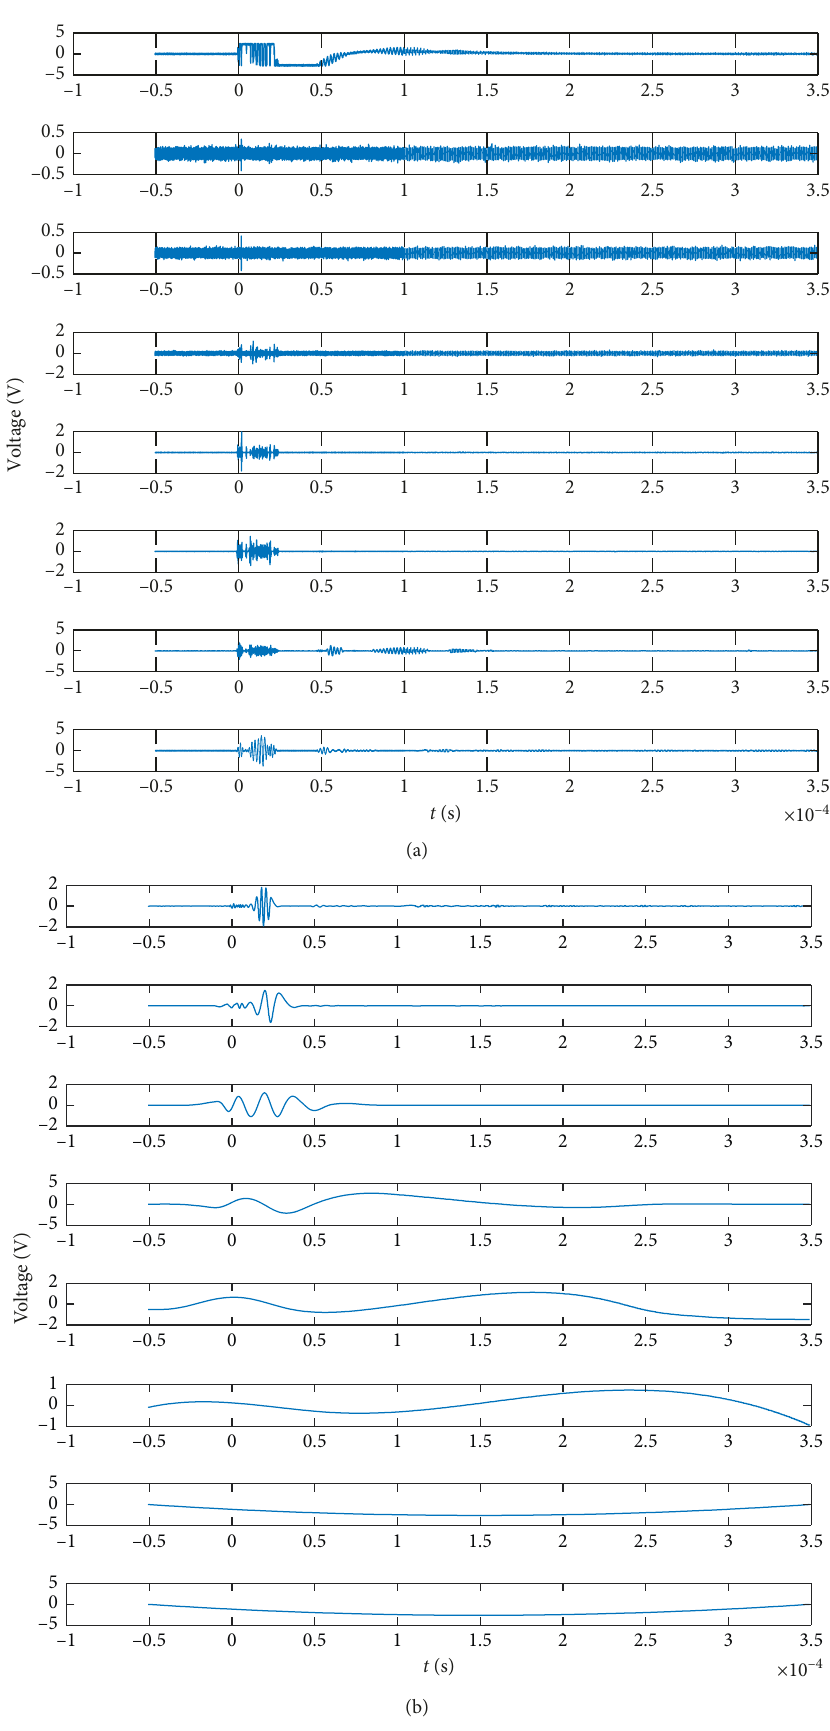
Figure 8: The IMF components obtained by the traditional EEMD method. (a) IMF 1–8. (b) IMF